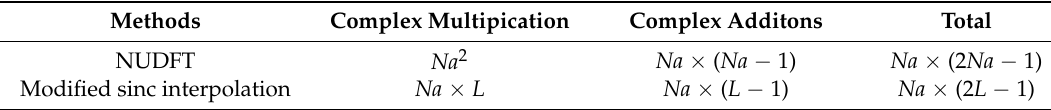
Table 2. Complexity of